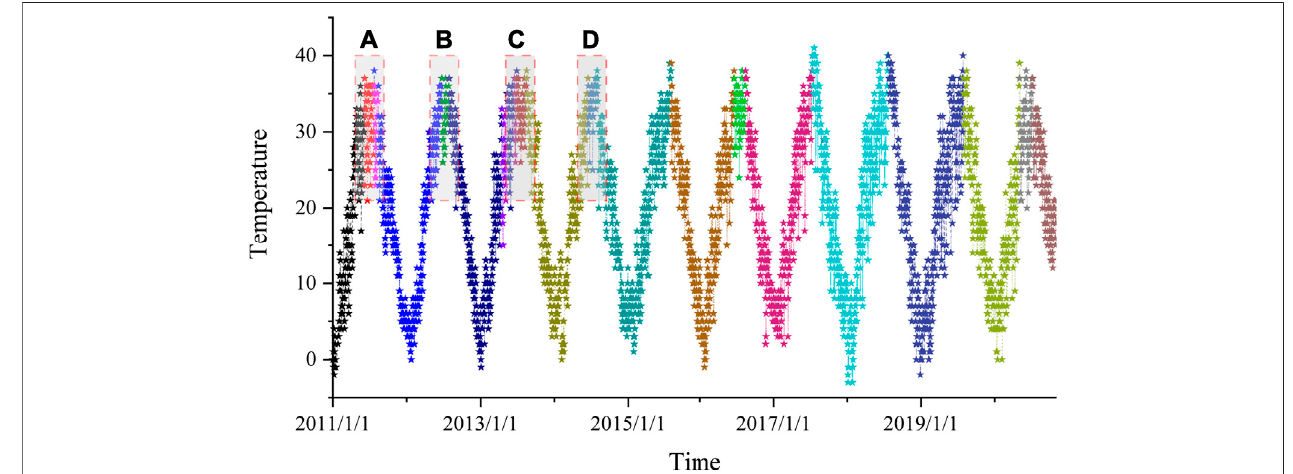
FIGURE 6 | Community structure of global temperature network.